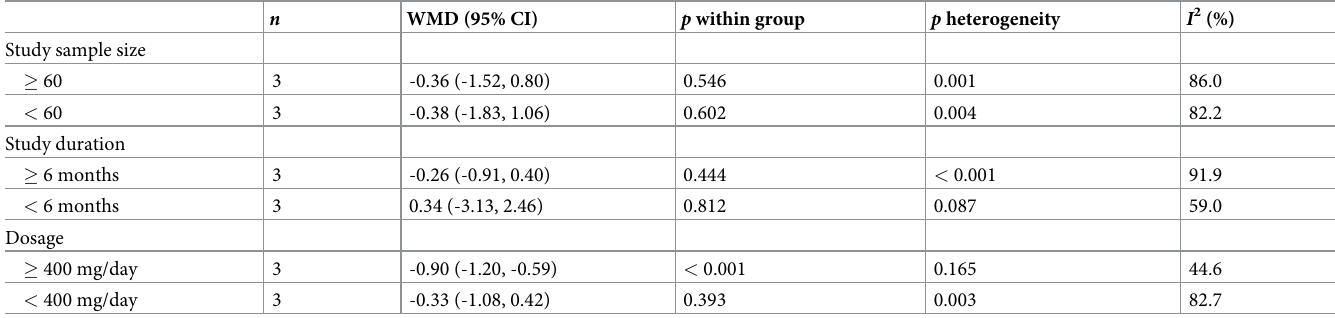
Table 3. Subgroup analyses of tocotrienols on malondialdehyde